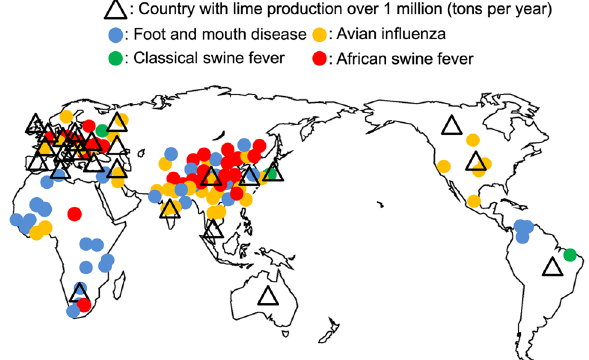
Figure 1. Locations of lime production and outbreaks of infectious diseases in domestic animals. Countries with lime production over 1 million tons per year, and locations of outbreaks of foot-and-mouth disease, avian influenza, classical swine fever and African swine fever in 2018–2019 (lime production was quoted from Mineral Commodity Summaries 2019 11 , and the location of livestock infectious diseases was quoted from the World Animal Health Information System Interface 2 , and we drew the world map summarizing